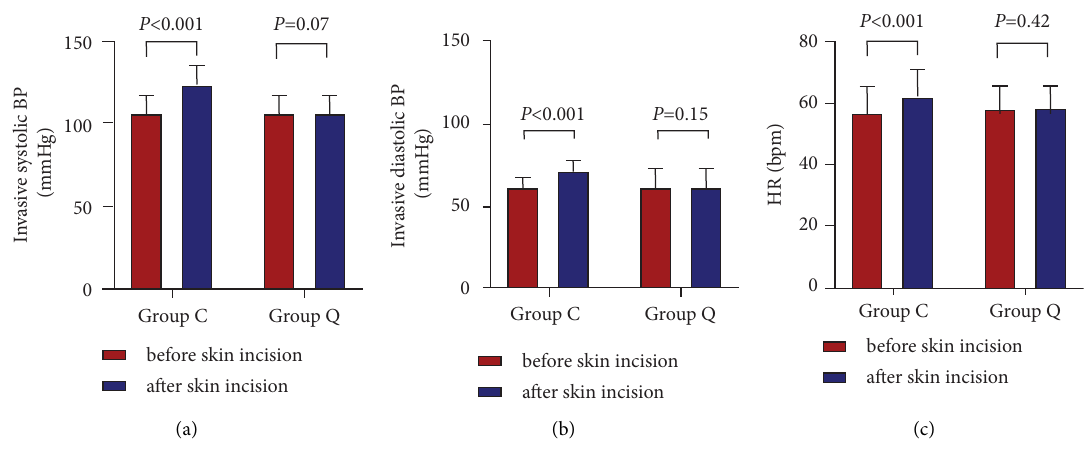
Figure 5: Comparison of BP and HR before and after skin incision. Table 2: NRS pain scores at rest and during activity in the PACU (T1) and 6h (T2), 12h (T3), 24h (T4), and 48h (T5) after